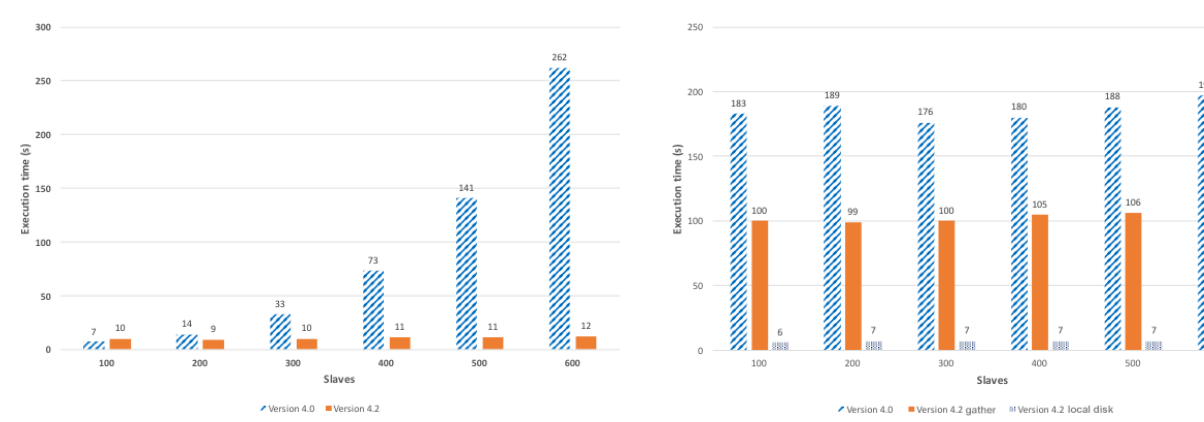
Figure 19. Execution time of the output phase at the UNA machine for 24h forecasting with the 20km grid spacing model configura-